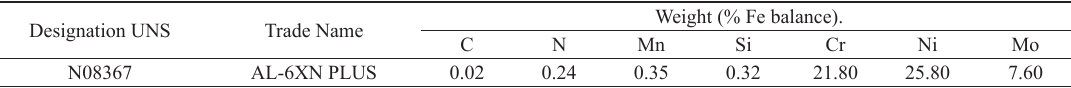
Table 1 . Chemical composition by optical emission spectroscopy (% by weight) of SASS AL-6XN PLUS 10 . Designation